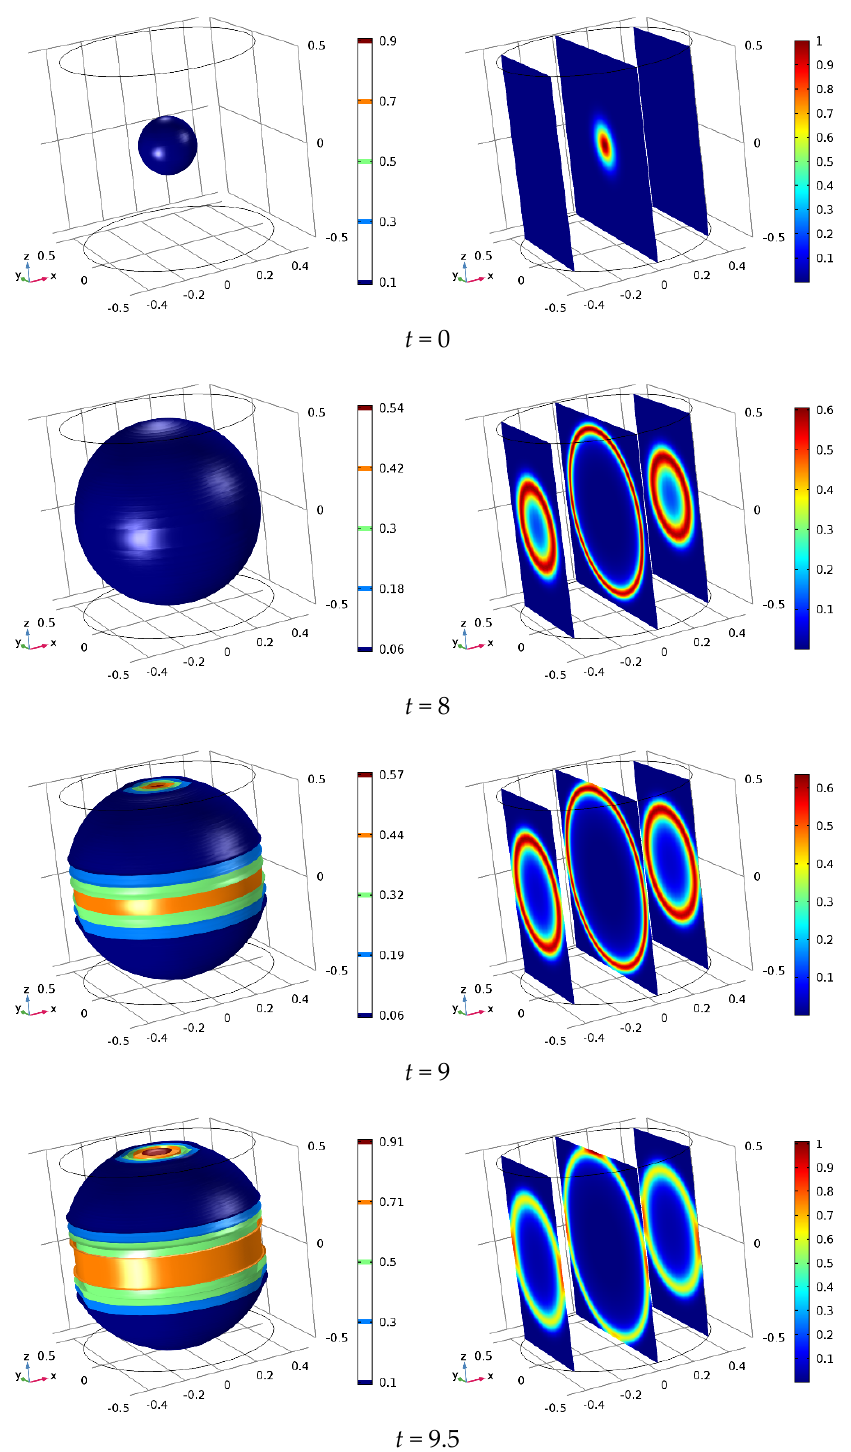
Figure 3. Cancer cell distribution inside the simulated domain during the time evolution, applying a uniform electric field in the negative z -axis direction with intensity E = 0.25. ( first column ) 3D iso-surface plots; ( second column ) Slices cutting the plots of the first column along planes normal to the x direction. Snapshots taken at t = 0, t = 8, t = 9, and t = 9.5. Figure 4 shows the concentration profile of cancer cells obtained along the vertical line cutting the simulated domain from ( x 1 = 0, y 1 = 0, z 1 = − 0.5) to ( x 2 = 0, y 2 = 0, z 2 = 0.5), from now on referred to as the vertical cutline, i.e., along the line splitting each central slice, shown in the second columns of Figures 1 and 3, into two symmetric domains with